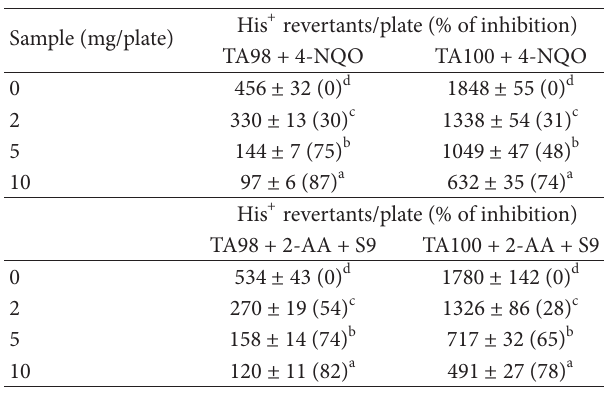
T 4: Effects of the aqueous extract of guava twigs (GTE) on butyl-hydroperoxide-(